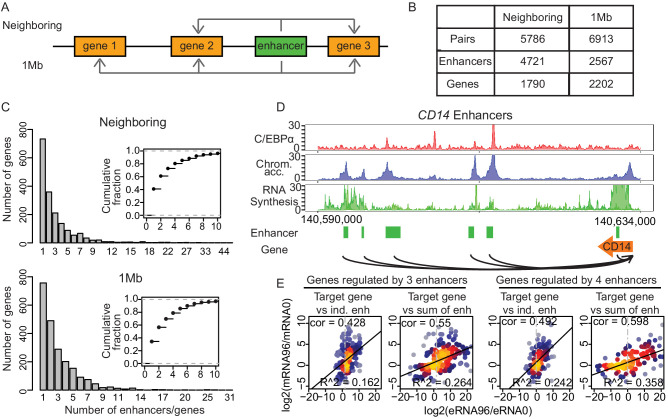
Multiple enhancers activate target gene promoters.(A) Schematic diagram describing ‘neighboring’ and ‘1 Mb’ enhancer–promoter pairing methods. With the neighboring method, enhancers are paired to the nearest upstream and downstream transcribed promoters. Pairs with differentially regulated promoters were taken for further analysis. With the 1 Mb method, enhancers were paired with all promoters within 1 Mb, which corresponds to the median width of a human topologically associating domain (TAD) (Dixon et al., 2012; Yan et al., 2017). Pairs with promoters and enhancers that are differentially regulated in a correlated manner were analyzed further (Materials and methods). (B) Number of enhancer–promoter pairs, enhancers and genes per pair and method. (C) 59.1% and 65.7% of genes are regulated by more than one enhancer when using the neighboring and 1 Mb method, respectively. (D) Multiple enhancer cooperation at CD14 gene is exemplified by the coverage tracks of indicated data sets at 96 hr. CD14 gene is regulated by six enhancers. BRD4, H3K4me1, and H3K27Ac coverage tracks at 0 hr and 96 hr are depicted in Figure 4—figure supplement 1E. (E) Scatterplot of log2 fold change of mRNA synthesis level at 96 hr compared to 0 hr and log2 fold change of eRNA synthesis from individual (ind.) or sum of all enhancers. Genes regulated by three enhancers (left) or by four enhancers (right) are shown. Spearman's correlation coefficients at the top left corner and adjusted R-squared (R2) values at the bottom right corner indicate that the sum of enhancer activity changes explains changes in mRNA synthesis better.